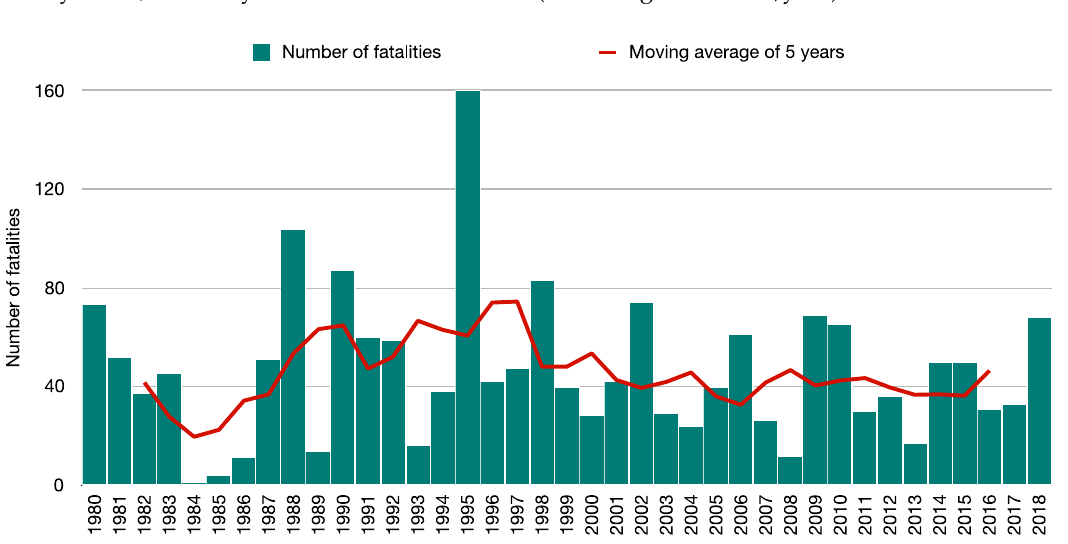
Figure 18. Yearly evolution of mortality by region (without Turkey above and including Turkey below) (we separated results with and without Turkey because the high number of deaths in Turkey does not allow seeing the distribution of annual mortality in the other countries).